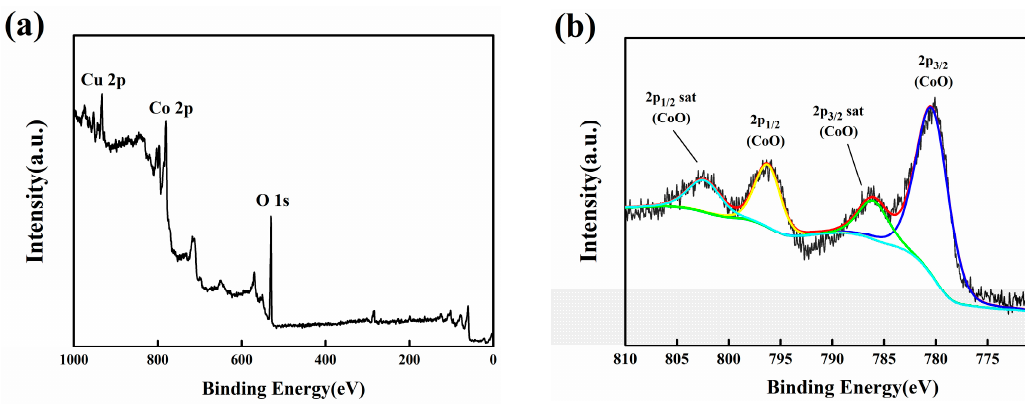
Figure 2. XPS survey spectrum ( a ) and spectra of Co 2p ( b ) performed on CoO-NFs.